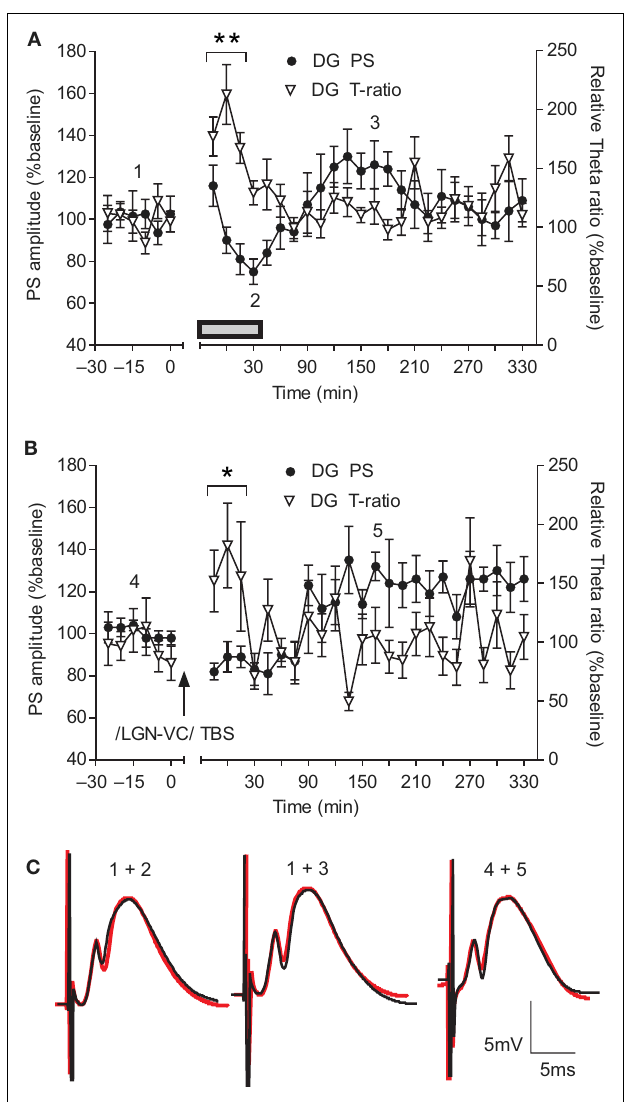
FIGURE 7 | Dentate gyrus excitability changes are paralleled by an increase in theta activity following either novelty exploration or thalamocortical stimulation. (A) Short-term depression occurs in the course of novelty exploration (signifi ed by the grey rectangle), and is followed by a subtle potentiation of the population spike (PS) in the dentate gyrus (DG) ( n = 6). The immediate response of theta oscillations, expressed by theta-ratio (T-ratio), occurs in parallel with the suppression of dentate gyrus excitability. (B) Theta-burst stimulation of lateral geniculate nucleus (LGN) results in a late- onset enhancement of the population spike response 90 min after the high- frequency protocol ( n = 5). This potentiation continued until the end of the recording period. Immediately after LGN stimulation an increase in the theta- ratio was observed in the dentate gyrus granule cell layer. (C) Analog traces represent an average of 5 fi eld potentials evoked at the points marked in the fi gures. The red traces reveal the fEPSP profi le of recorded potentials during the baseline period (marked with 1 and 4, respectively). Note the increase of PS paralleled by no change of the fEPSP slope. Horizontal bar: 5 ms, vertical bar: 5 mV; * p < 0.05 versus baseline